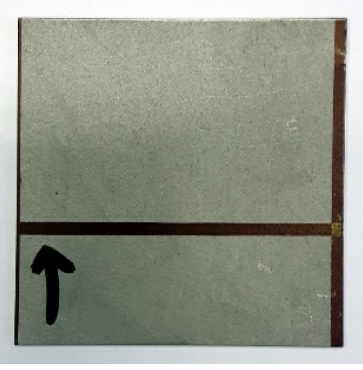
Figure 2. Plate made from Ti6Al4V.